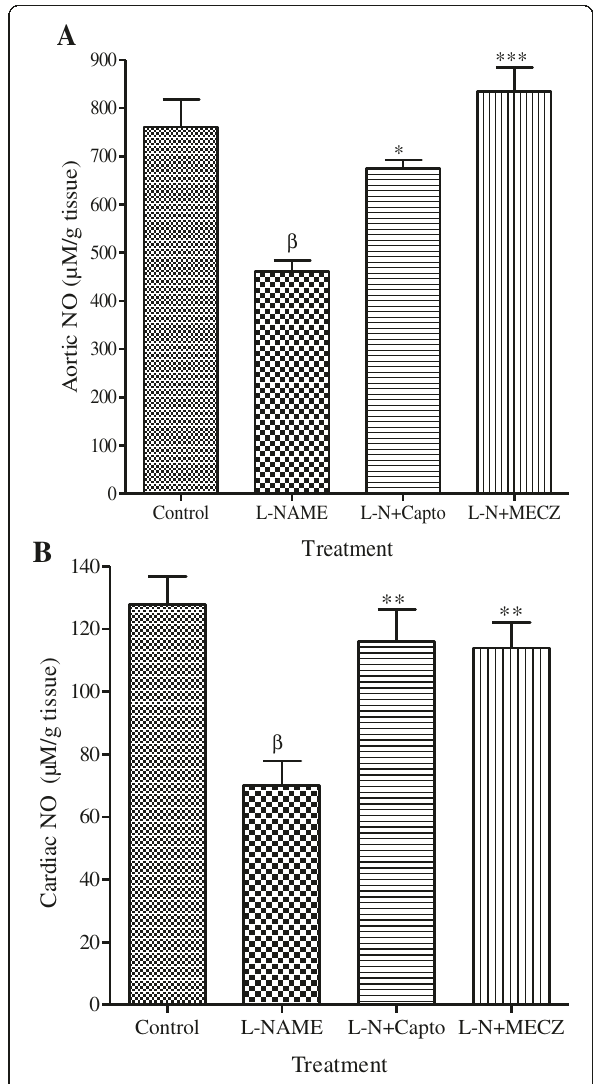
Figure 6 Effects of the chronic treatment on aorta and cardiac NO content. Values are Mean±SEM (n=5); β p<0.01 significantly different compared to the control group; *p<0.05, **p<0.01 and ***p<0.001 significantly different compared to the L-NAME group.